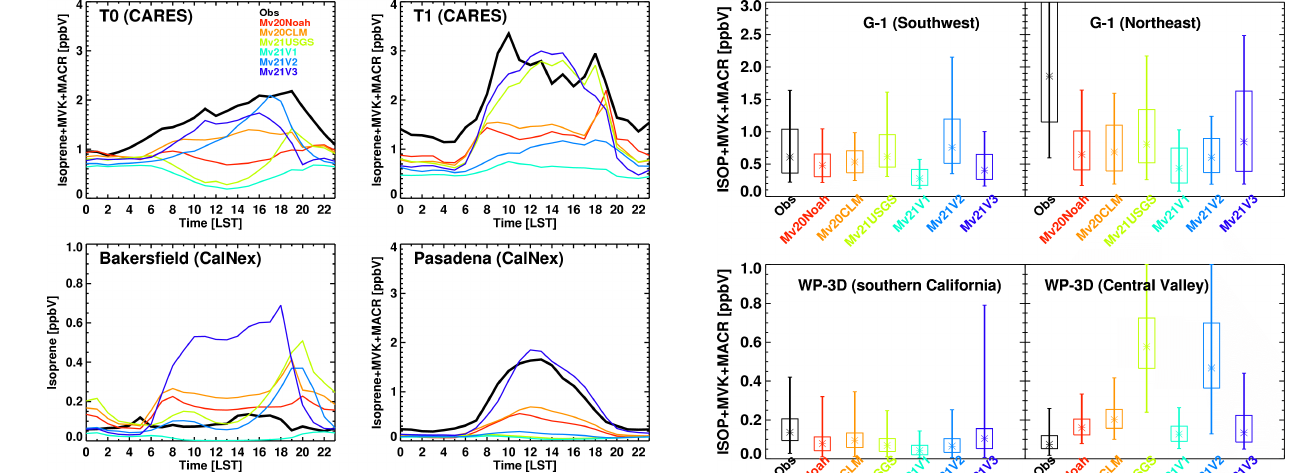
Figure 14. Monthly averaged diurnal variation of surface iso- prene + MVK + MACR mixing ratios at the three observation sites and isoprene mixing ratios at the Bakersfield site from the obser- vations and six simulations listed in Table 2. The simulated values for the Bakersfield and Pasadena sites are averaged for the first two weeks of June to be consistent with the observations.